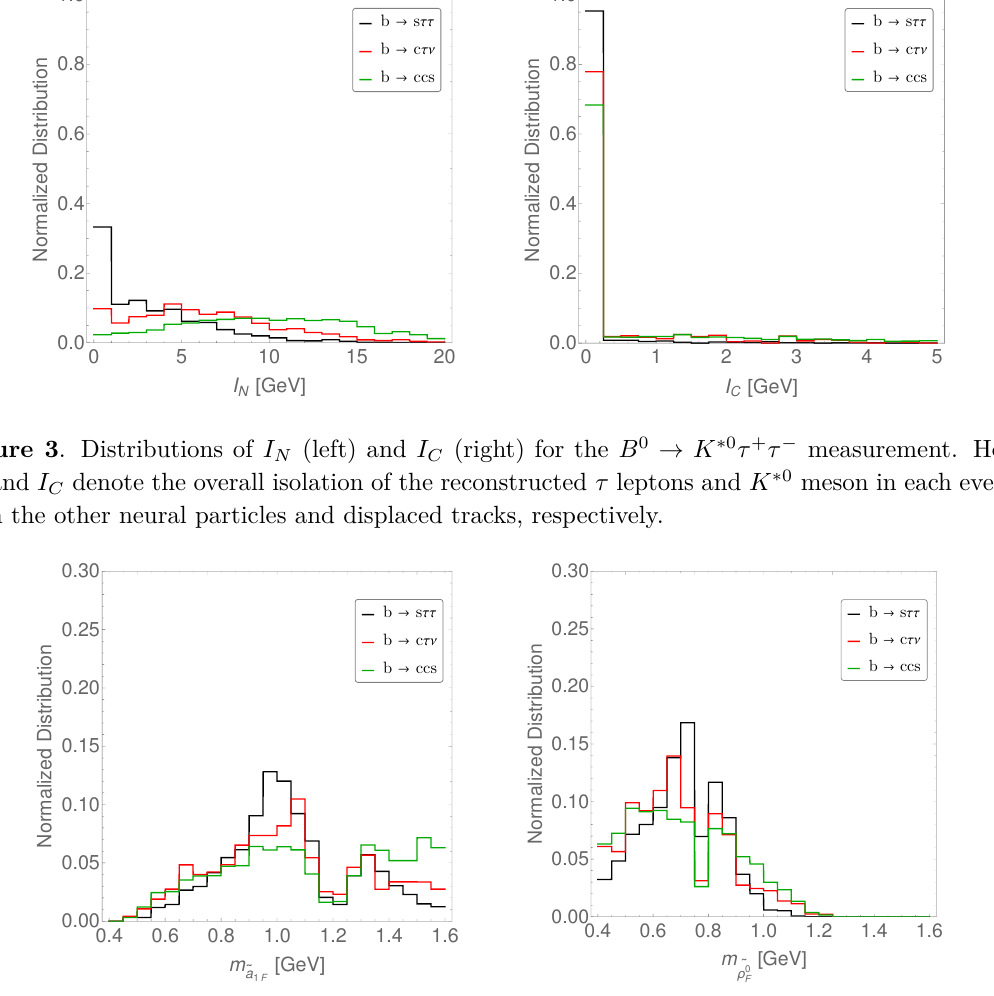
Figure 4 . Distributions of m ˜ a Here the subscript “ F ” represents one of the two reconstructed a ± deviating more from the physical